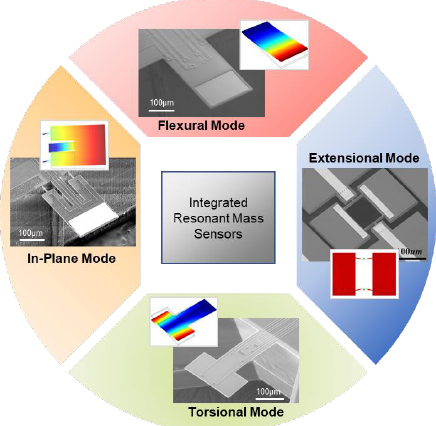
Figure 1. Integrated resonant gravimetric sensors using different vibrational modes, such as bend- ing, torsional, in-plane, and extensional modes. Reprinted with permission from [17,19,20,26]. Cop-